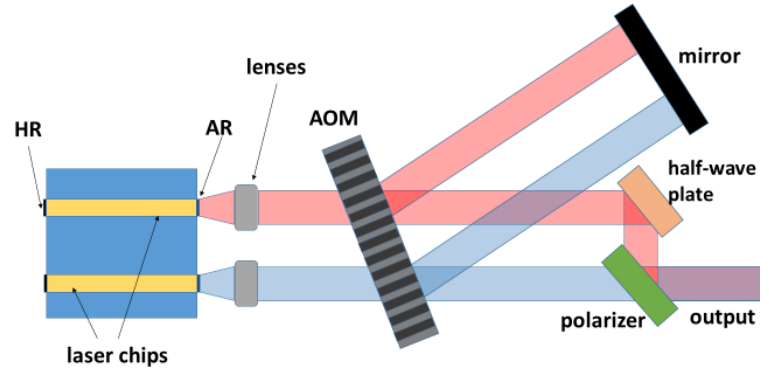
Figure 11. Configuration for extracting higher power output form the AOM-tuned QCL.